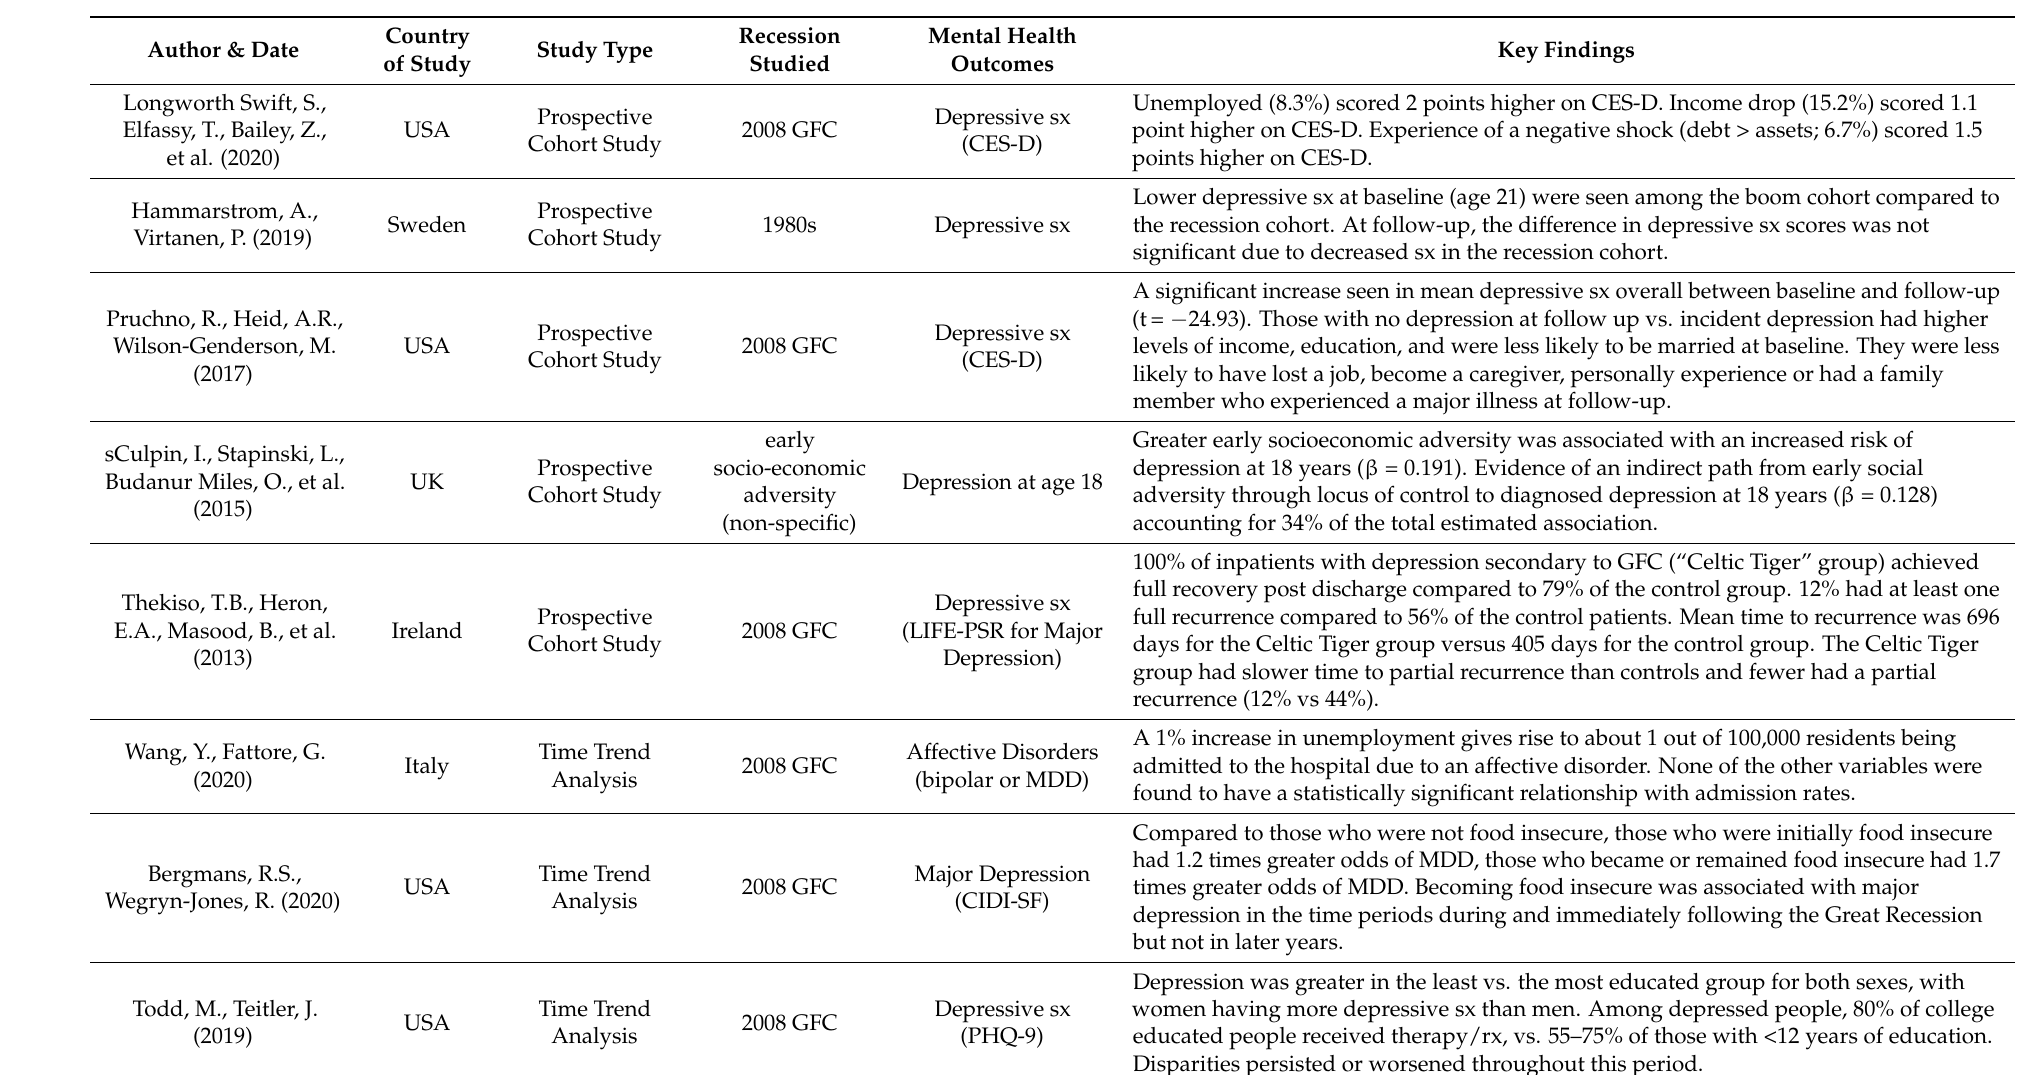
Table 1. Summary of included articles on depression only (N =